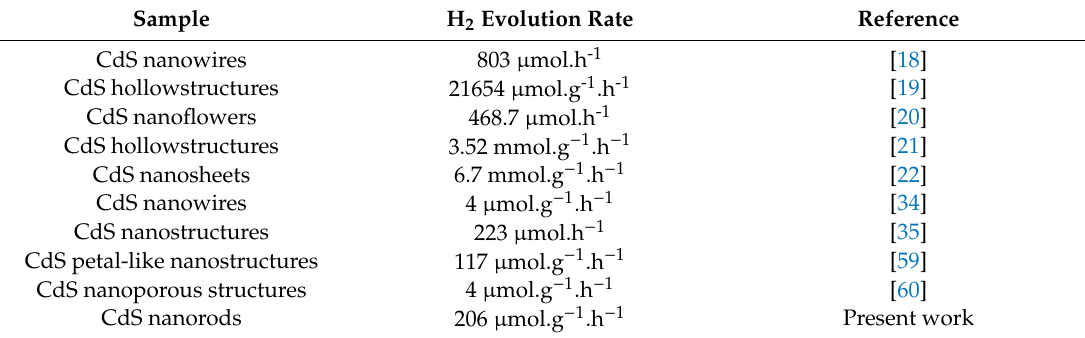
Figure 12. ( a ) H 2 evolution activities and ( b ) rates of CdS NR photocatalyst samples obtained at different reaction times. Table 2. Comparison of the H 2 evolution rates of CdS photocatalysts.